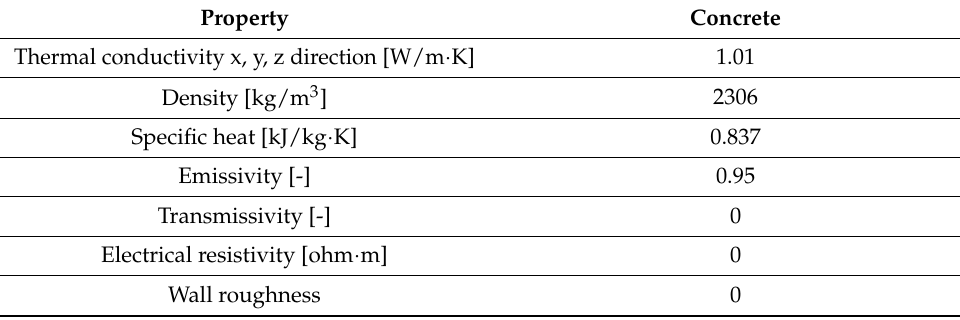
Table 3. Thermophysical properties of concrete implemented in CFD.